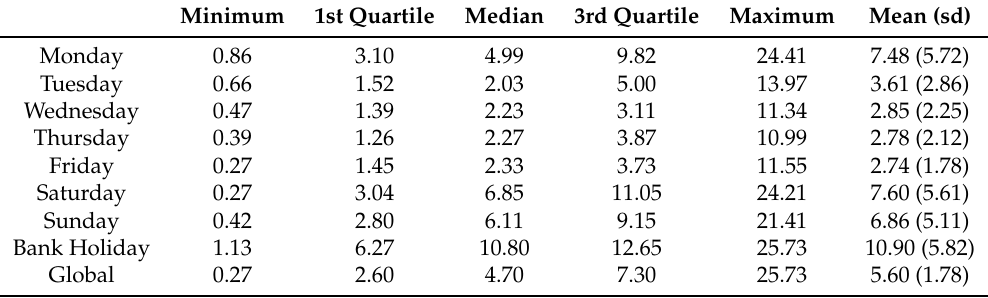
Table 8. MAPE (in %) for the persistence-based forecasting